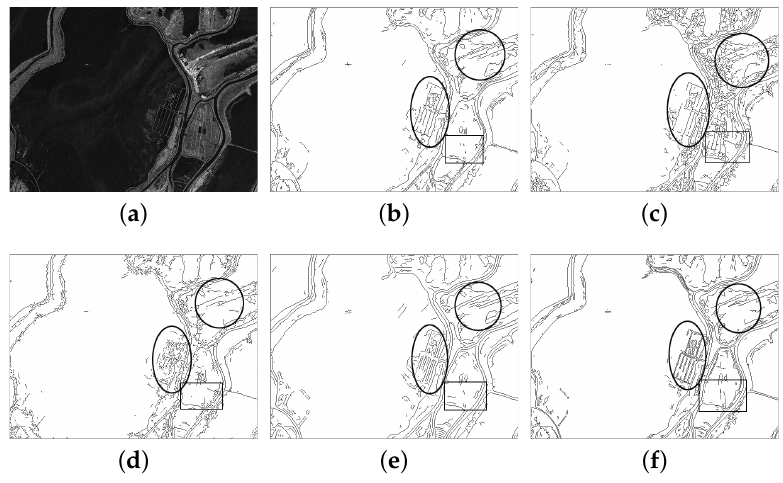
Figure 16. Results on the first satellite SAR image. ( a ) The raw image; ( b ) SAR-PC; ( c ) PC; ( d ) Log-PC; ( e ) RBED; ( f ) GSS.